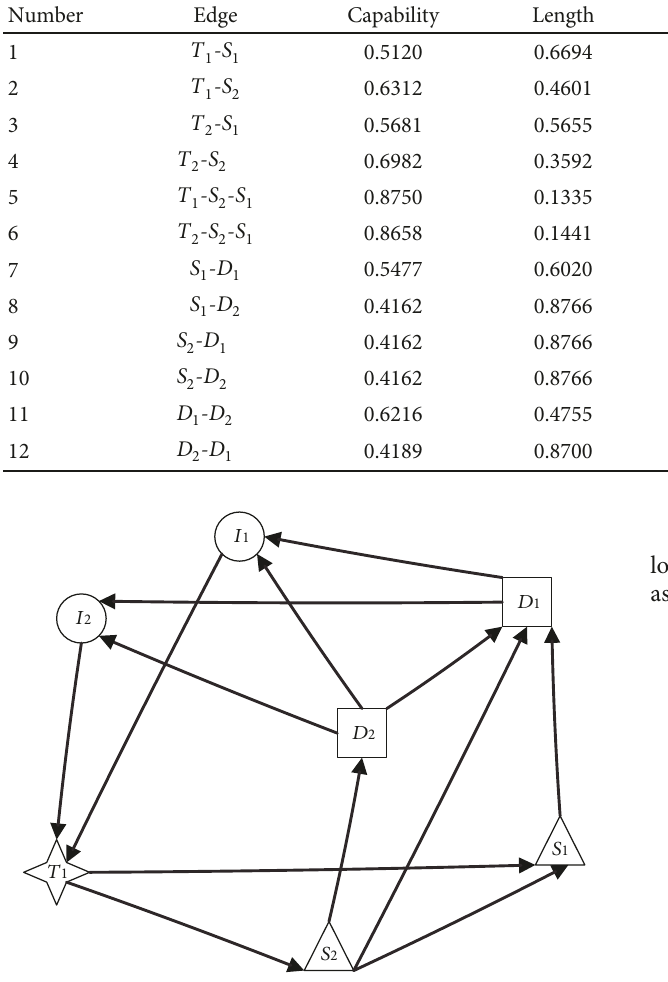
Figure 4: MAV/UAV collaborative combat network aimed at target T 1